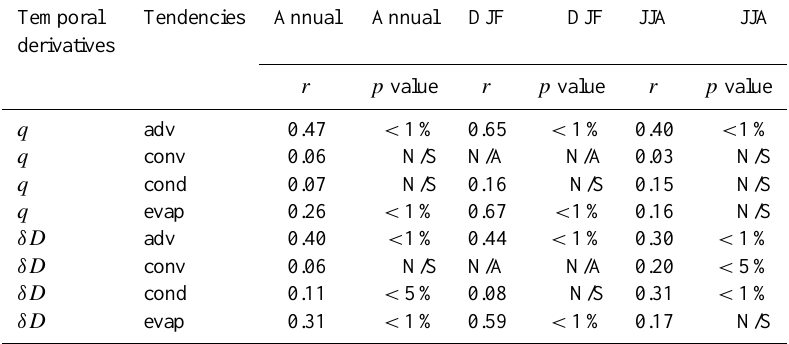
Table 6. Daily correlation coefficient ( r ) and its significance ( p value) between temporal derivatives of q or δD and tendencies from different processes simulated by LMDZ: horizontal advection (adv), deep convection (conv), large-scale condensation and re-evaporation (cond), surface evaporation and boundary-layer dynamics (evap). N/S means “not